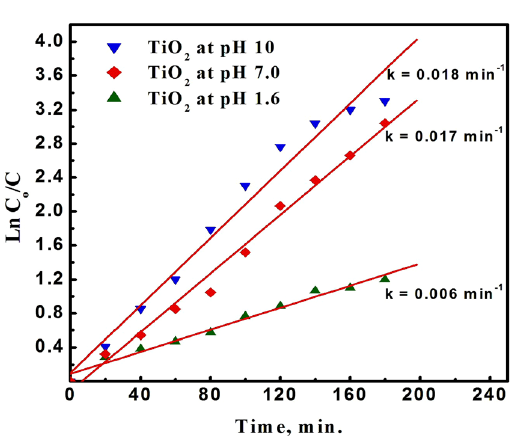
Figure 8. Photodegradation efficiencies of TiO 2 NPs prepared at different pH values; 1.6, 7.0 and 10.